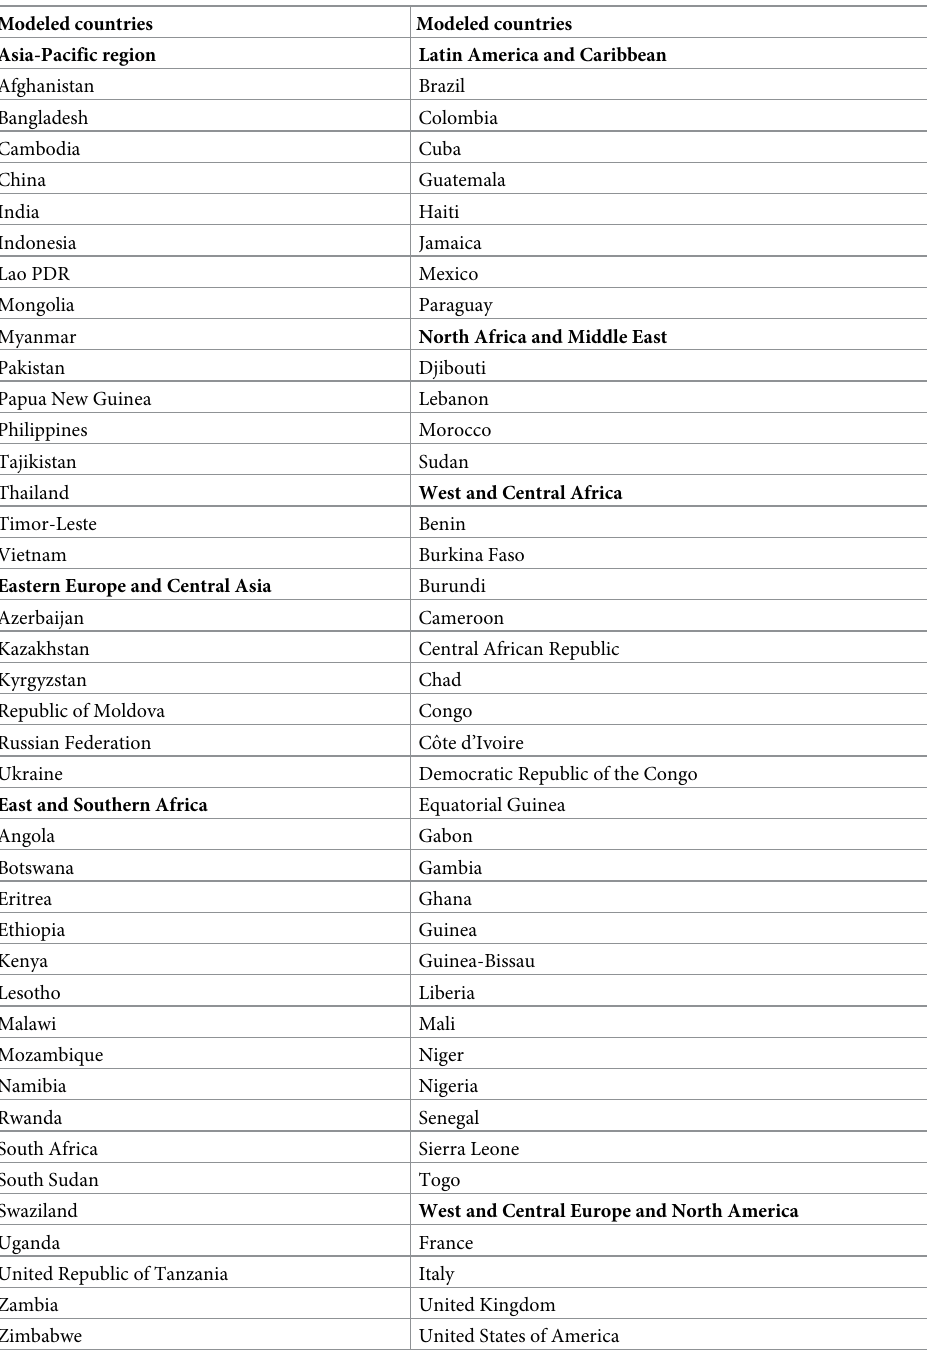
Table 1. Countries modeled with